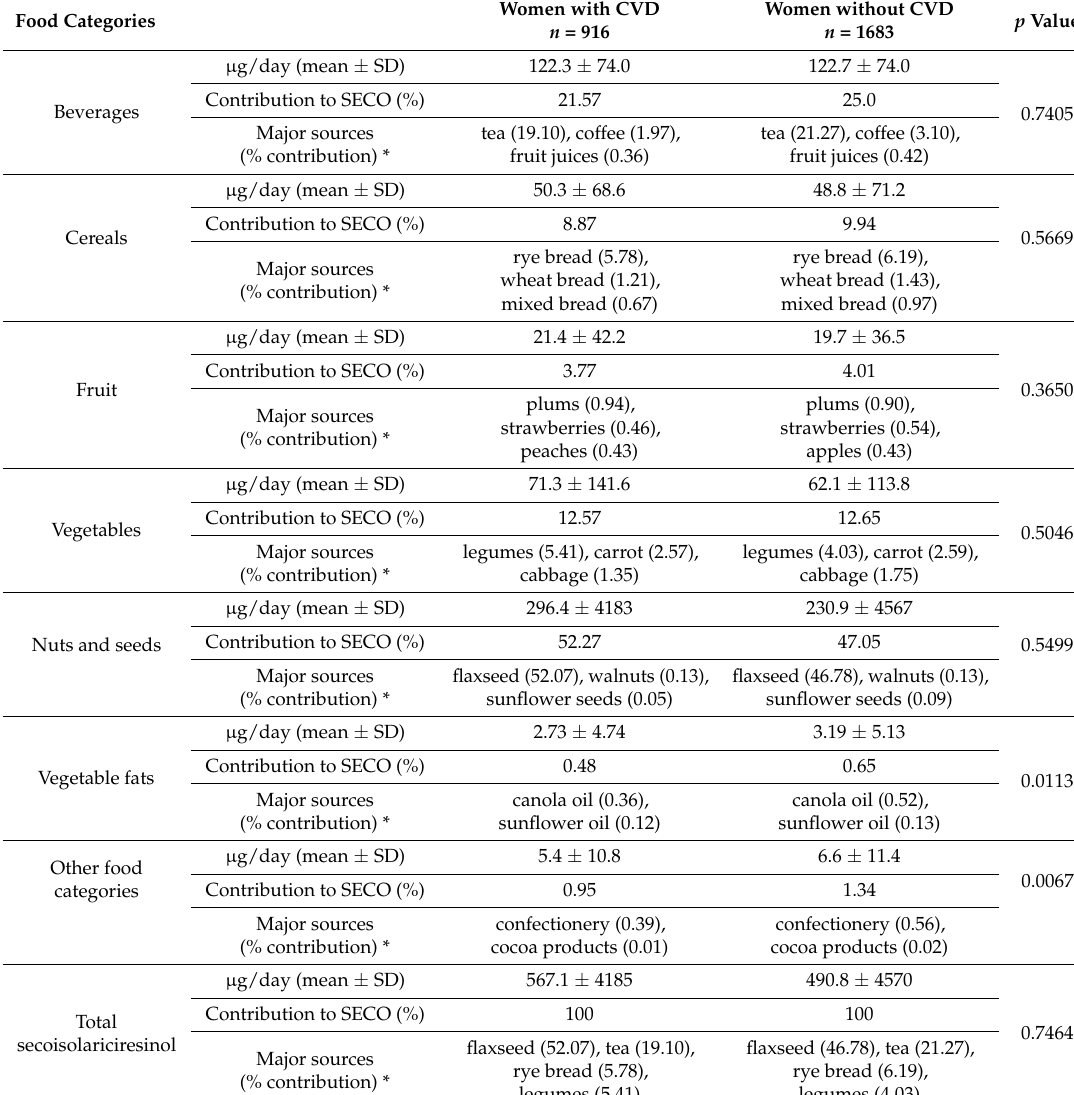
Table 3. Contributions of food categories and individual food products to secoisolariciresinol (SECO) intake in women with and without